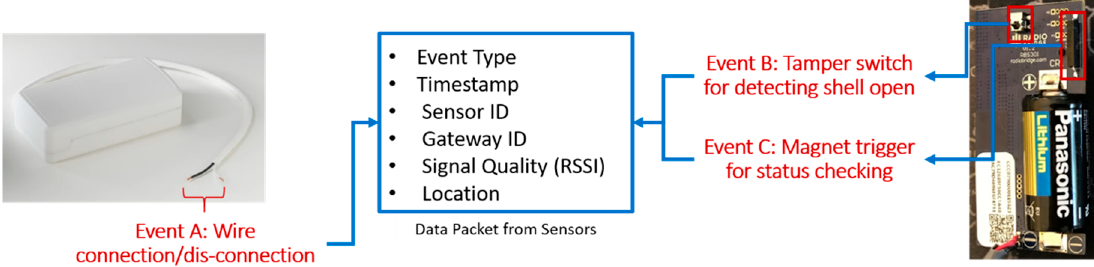
Figure 3. Radio Bridge LoRaWAN Dry Contact Sensor Module, events, and data packet structure.